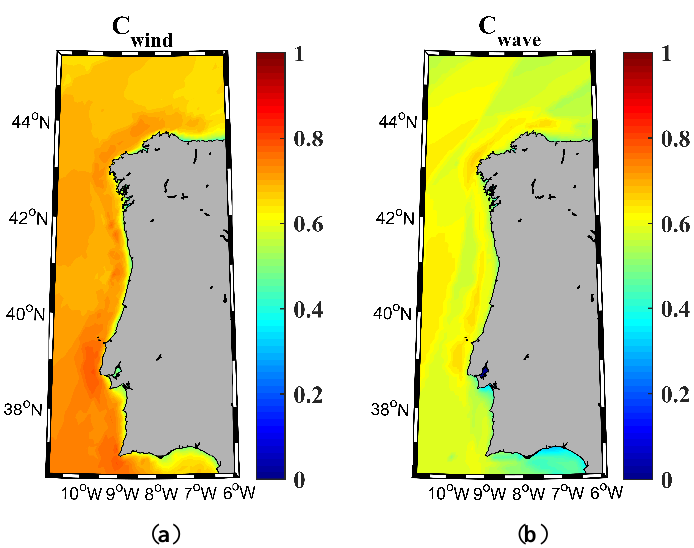
Figure 8. Classification of the wind ( a ) and wave ( b ) energy resource in the NW Iberian Peninsula for the near future (2026–2045).